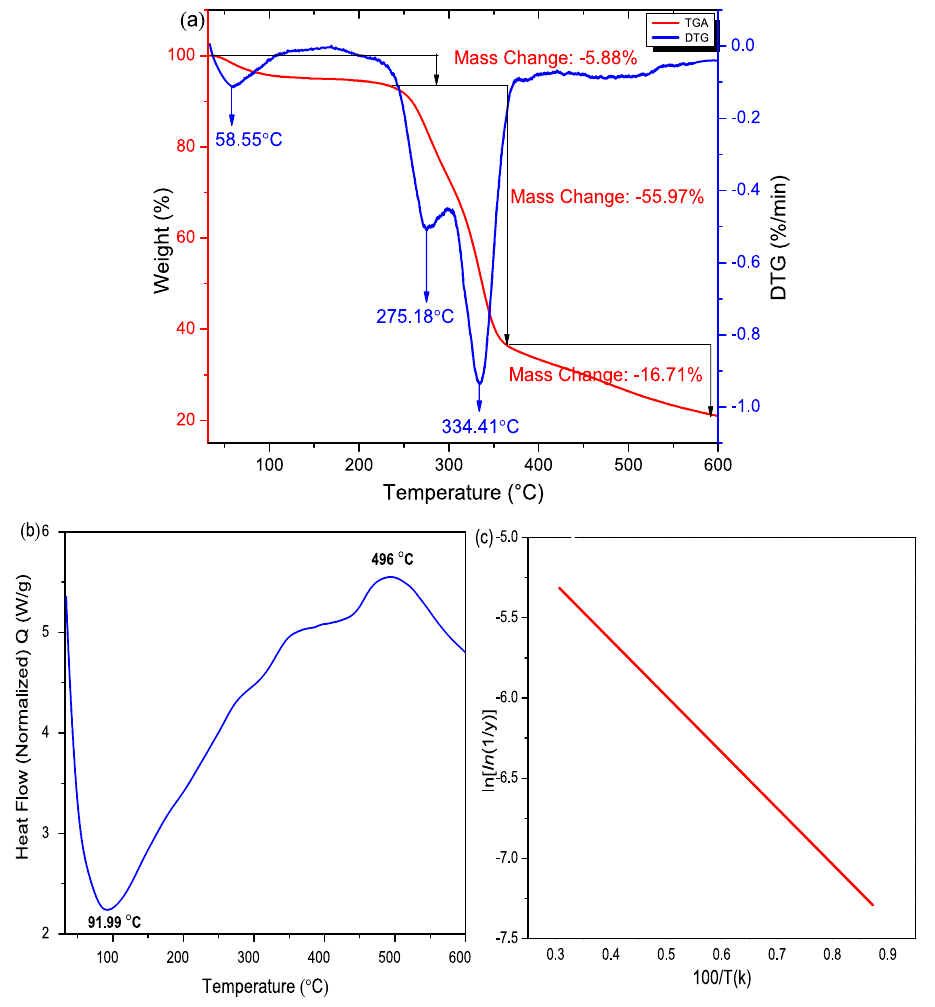
Figure 9. TGA ( a ), DSC ( b ) and Broido’s plots ( c ) of CTF fiber.